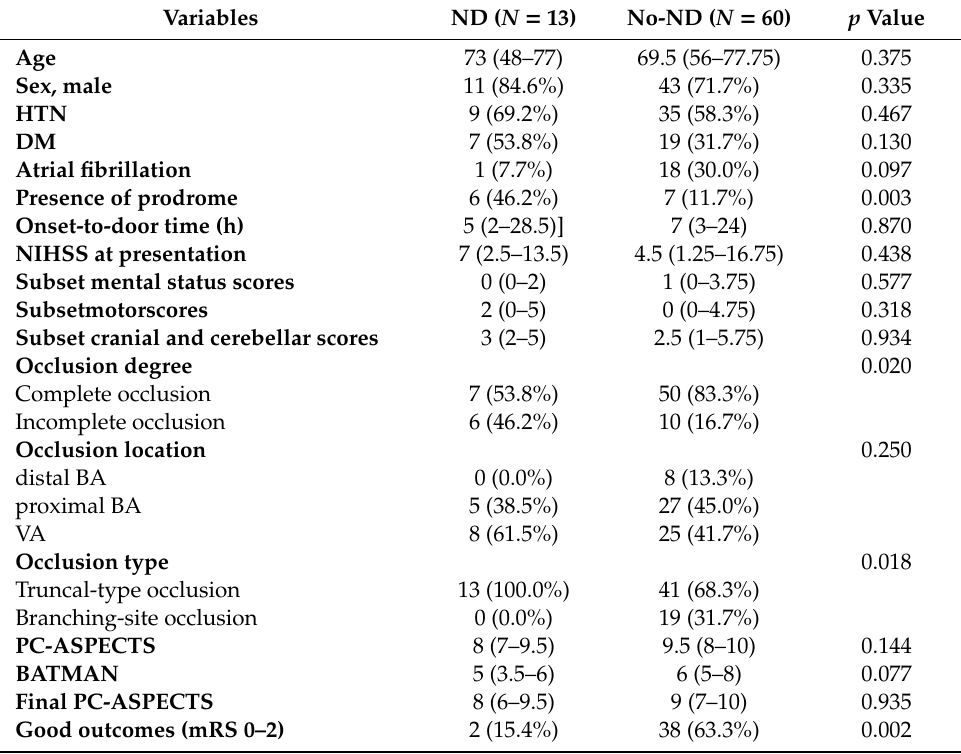
Table 3. Comparison of patients who experienced neurological deterioration and who did not, in those that did not undergo endovascular treatment.